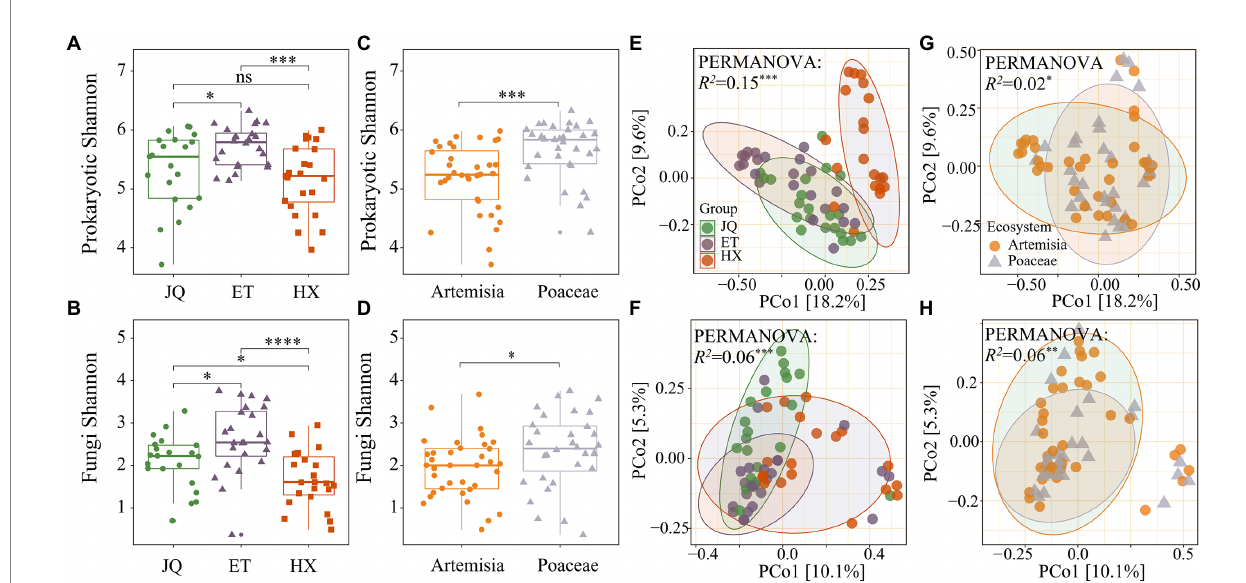
FIGURE 2 Alpha diversity of prokaryotic and fungal phyla across three regions (A,B) and two habitats (C,D) . PCoA of prokaryotic and fungal phyla across three regions (E,F) and two habitats (G,H) . *, **, *** indicate significance at the 0.05, 0.01 and 0.001 levels, respectively.